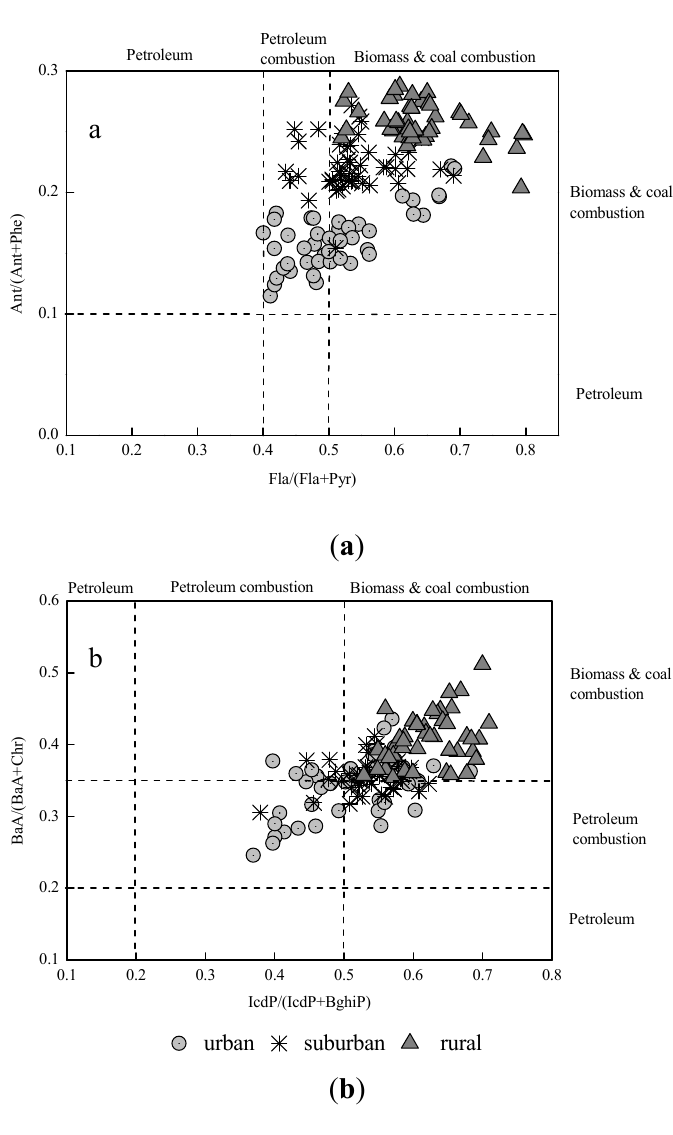
Figure 3. Cross-plot of the isomeric ratios of: ( a ) Ant/(Ant+Phe) vs. Flu/(Flu + Pyr),